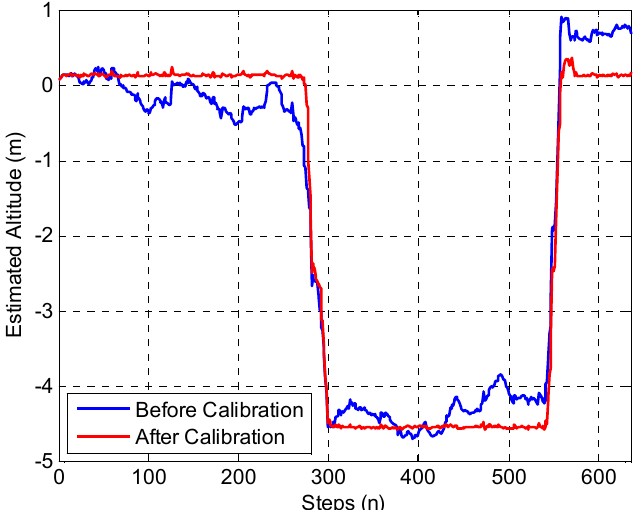
Figure 11. Performance of Altitude Bias Calibration.